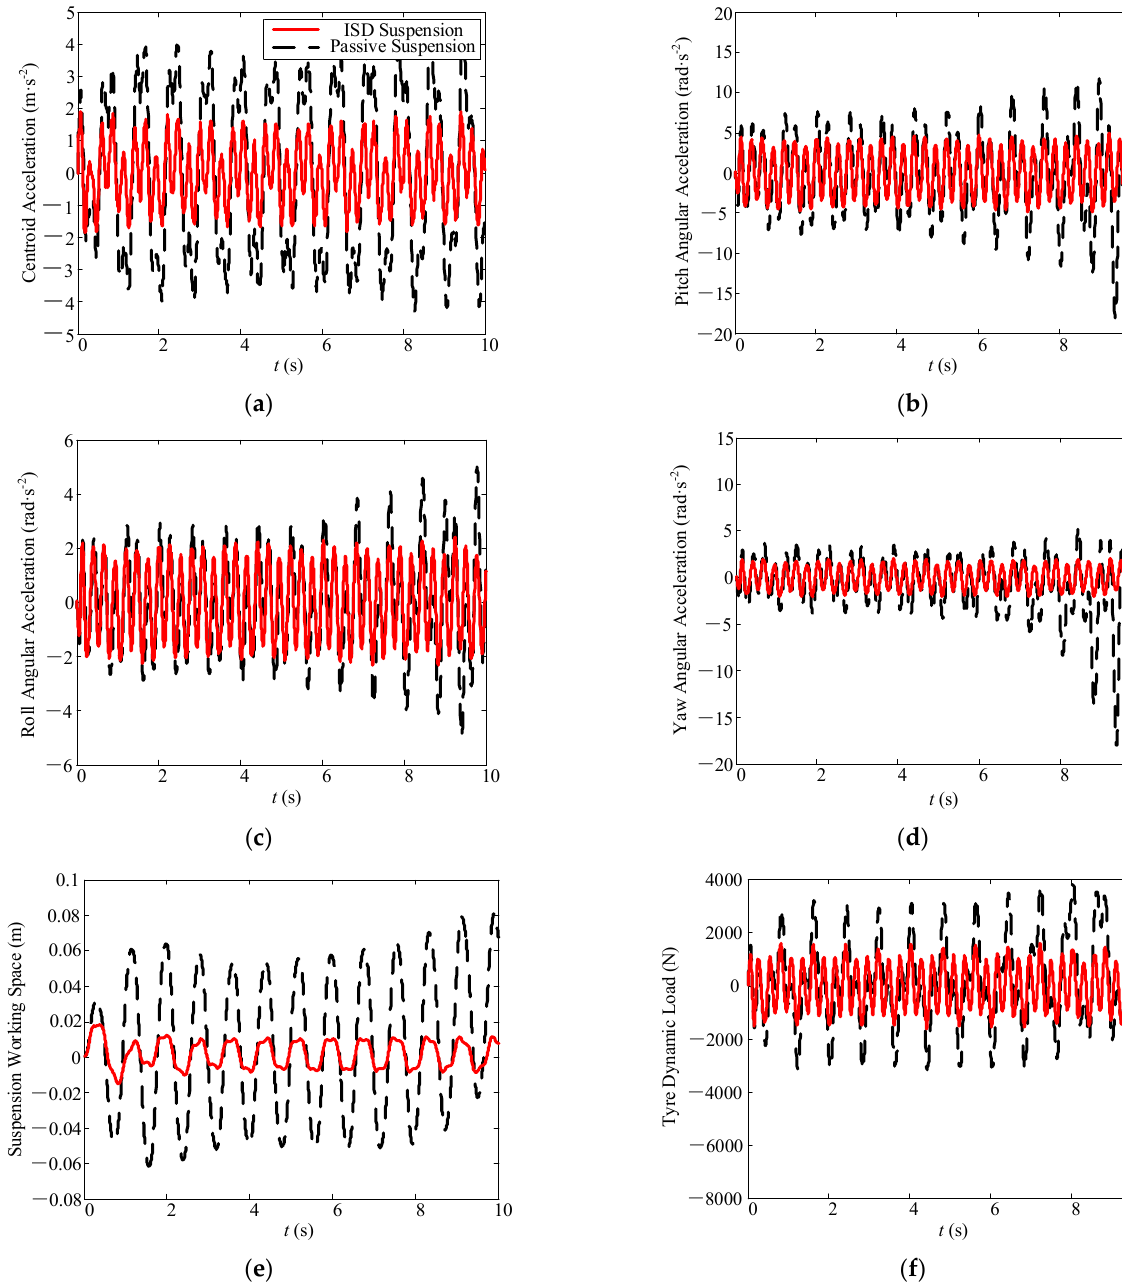
Figure 11. The objective function value under coupled road excitation.